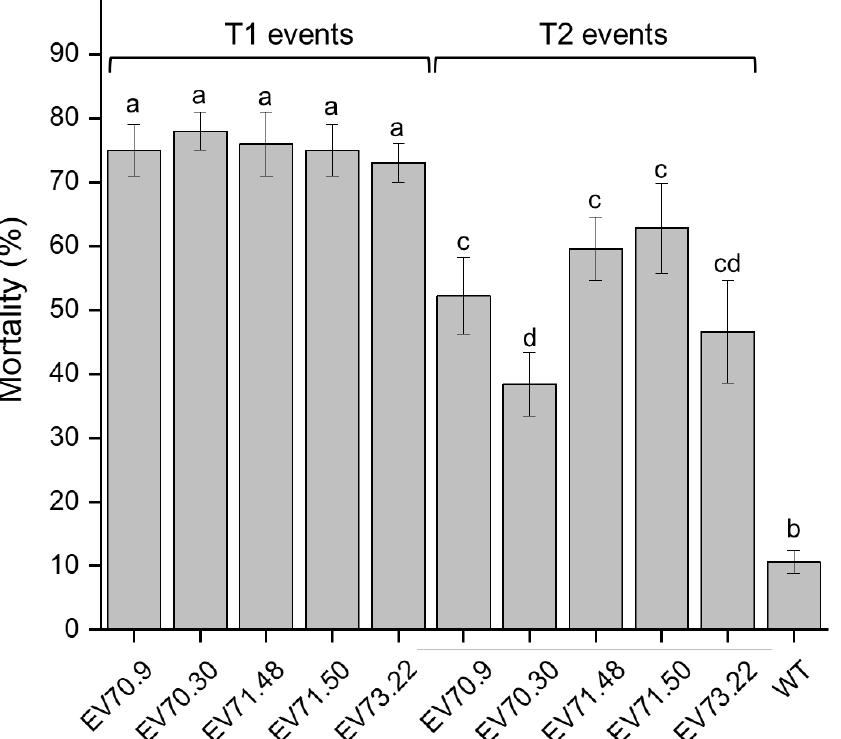
Figure 4. Mortality of A. grandis after 30 days of oviposition in cotton floral buds. Individual CBW insects fed on transgenic cotton plants from different transformed events are compared with insects fed on wild-type cotton (WT). Error bars show the standard error mean (SEM) from the six individual plants evaluated per event. Lowercase letters indicate significant differences between treatments (ANOVA one-way-Post hoc Tukey, p -value < 0.01; N: 15 insects per